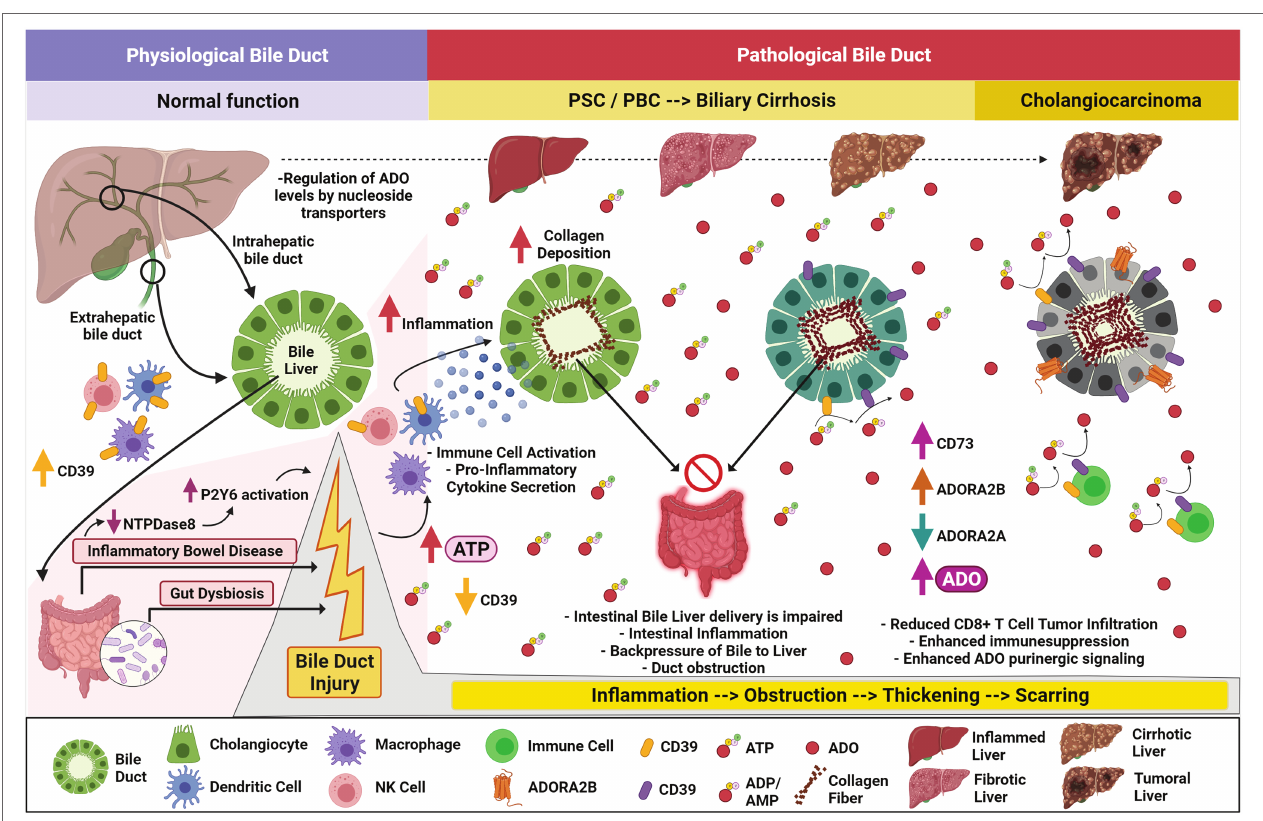
FIGURE 2 | Purinergic signaling in cholestatic liver disease, biliary cirrhosis, and development of cholangiocarcinoma. Ectonucleotidase-expressing immune cells, pancreatic acinar cells, and cholangiocytes help balance gut-derived ATP levels arising within the hepatopancreatobiliary tract. During Inflammatory Bowel Disease (IBD) with associated gut dysbiosis, increased levels of ATP are secreted impacting physiological bile duct function and provoking further cholestasis. Decreased intestinal ENTPDase8 promotes enhanced P2Y 6 activation and exacerbates the inflammatory phenotype. Immune cells may lose CD39 expression, allowing systemic ATP accumulation with activation of dendritic cells, macrophages, and NK cells. This effect is pronounced when in presence of CD39-deprived macrophages. The activated immune cells secrete pro-inflammatory signals when these cells arrive within the pancreatobiliary tract promoting cholangiocyte inflammation. Primary Sclerosing Cholangitis (PSC) and Primary Biliary Cholangitis (PBC) are associated with chronic ductular injury, impairing intestinal bile liver delivery, promoting backpressure to the liver, and exacerbating intestinal inflammation. Chronic inflammation and intra bile duct fibrosis trigger duct obstruction, thickening, and scarring which leads to biliary cirrhosis. Decreased A 2A R and elevated CD73 and